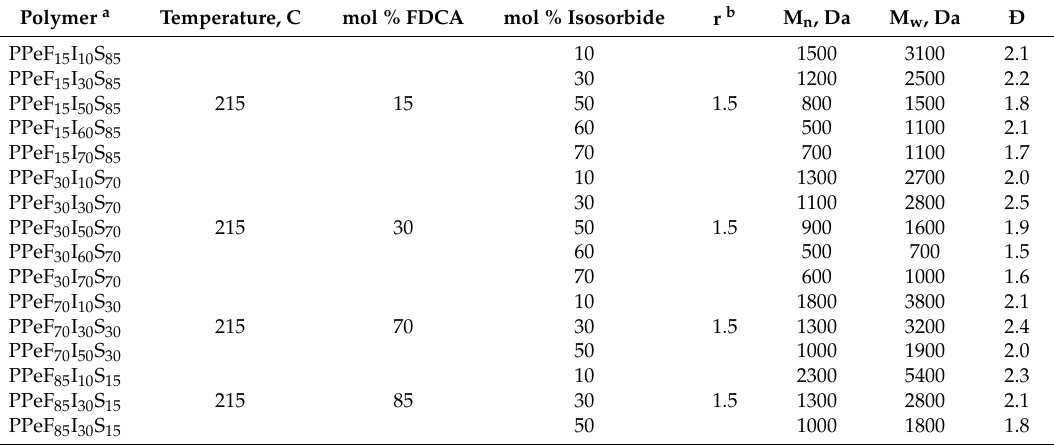
Table 2. Synthesized biomass-derived polyesters with 1,5-pentanediol and isosorbide (PPeFIS). Polymer